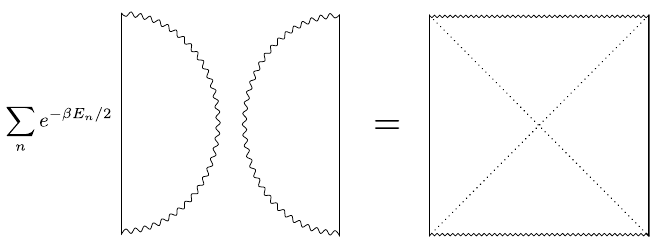
Figure 2 . Schematic of ER = EPR . The connected, two-sided, asymptotically AdS black hole admits a dual description as an entangled superposition of disconnected spacetimes, represented schematically by the wedges on the left, each of which is dual to an energy eigenstate | n i the two copies of the boundary CFT. The ER = EPR correspondence asserts that this equivalence of entangled quantum states to connected spacetimes holds more generally. We find examples of string dualities of this type, relating a string in a connected target space to a string in an entangled superposition of disconnected